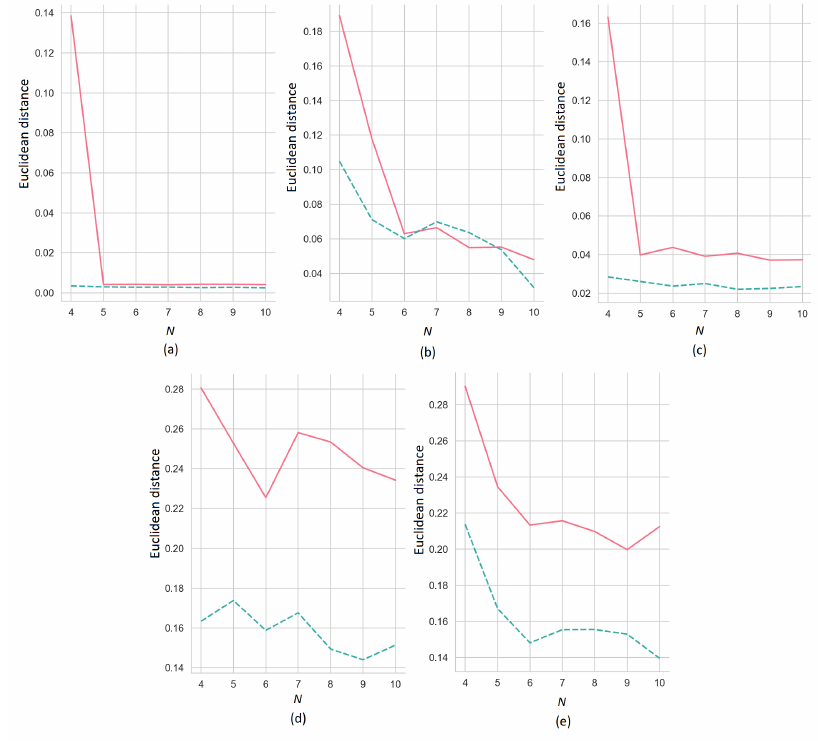
Figure 9. Euclidean distances between ERW-SHAP and SHAP as functions of N for t = 2 (the solid line) and 3 (the dashed line) for five datasets depicted in corresponding Figure 4a–e and trained SVMs as black-boxes.